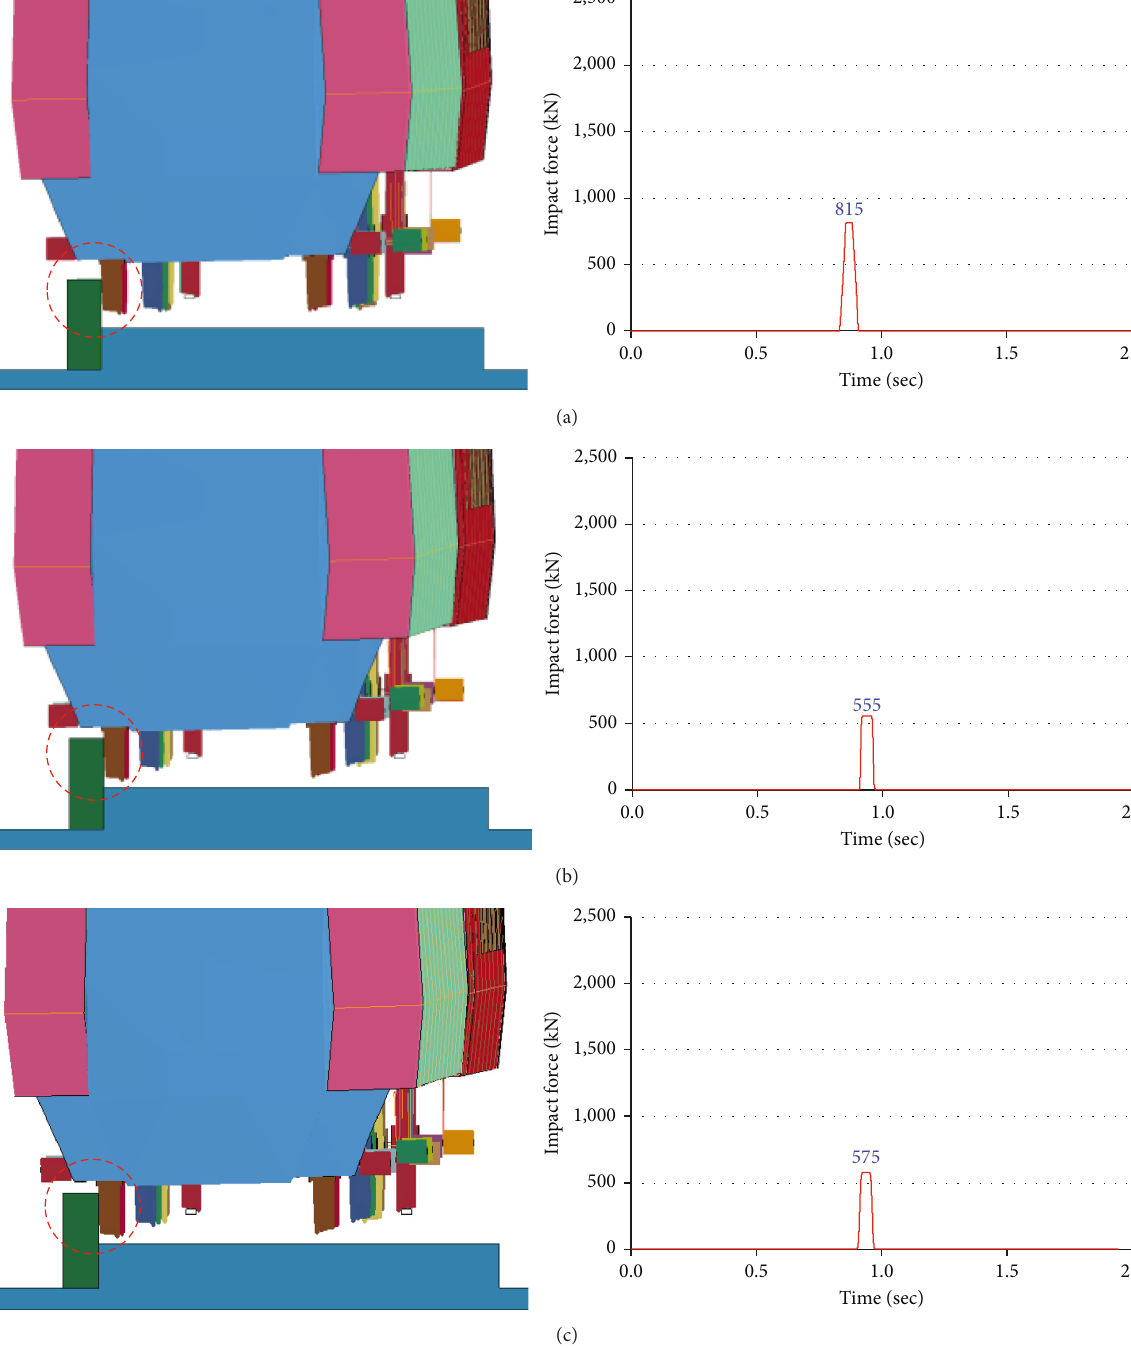
Figure 22: Impact force according to the collision conditions. (a) Derailment-collision behavior 1. (b) Derailment-collision behavior 2. (c) Derailment-collision behavior